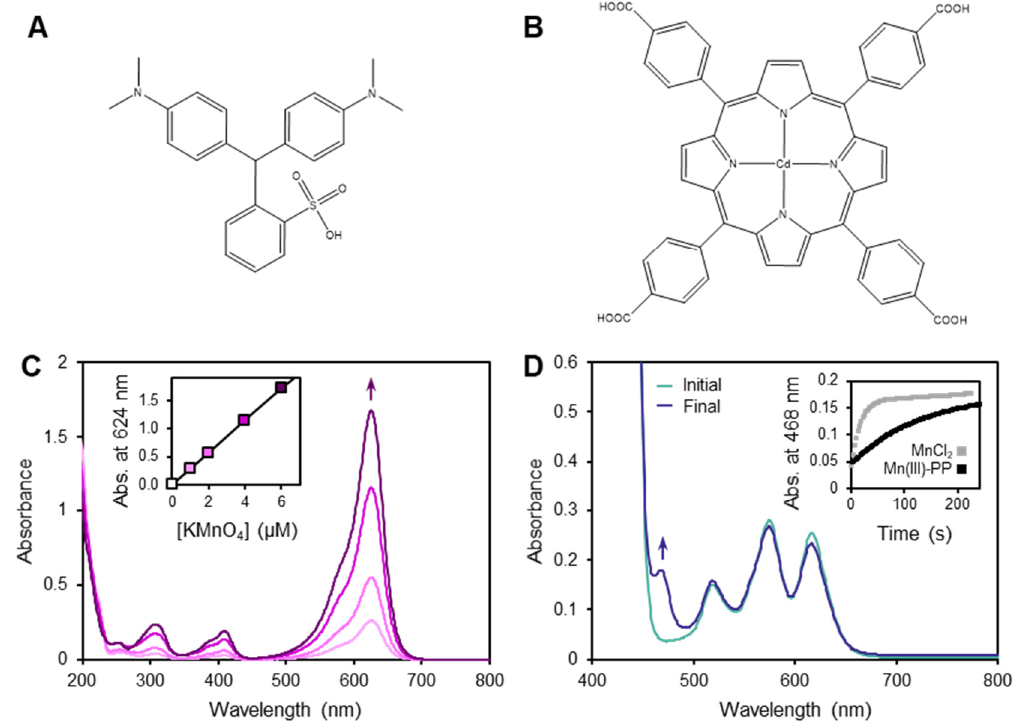
Figure 1. Leucoberbelin blue (LBB) and Cd-porphyrin (TCPP) spectrophotometric methods for detecting manganese species. ( A , B ) Chemical structures of the LBB ( A ) and Cd(II)–TCPP ( B ) reagents. ( C , D ) UV–vis absorbance spectra illustrating the application of these methods. ( C ) LBB method on a standard curve of KMnO4 solutions, with the inset showing the linear absorbance change at 624 nm with KMnO 4 concentration due to oxidation of LBB. ( D ) TCPP method on a standard solution of MnCl 2 , showing the change in absorbance at 468 nm from Mn(II) substitution and oxidation to generate Mn(III)–TCPP. Inset shows the kinetic profile of this reaction, along with the Mn(III)–PP ligand-exchange reaction to generate Mn(III)–TCPP.